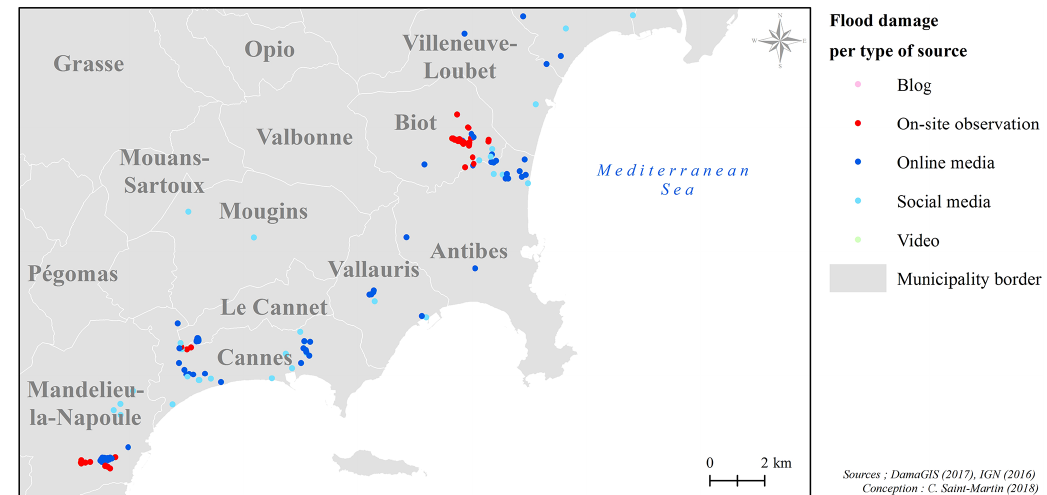
Figure 8. Spatial distribution of damage from 3 October 2015 flood according to their sources.